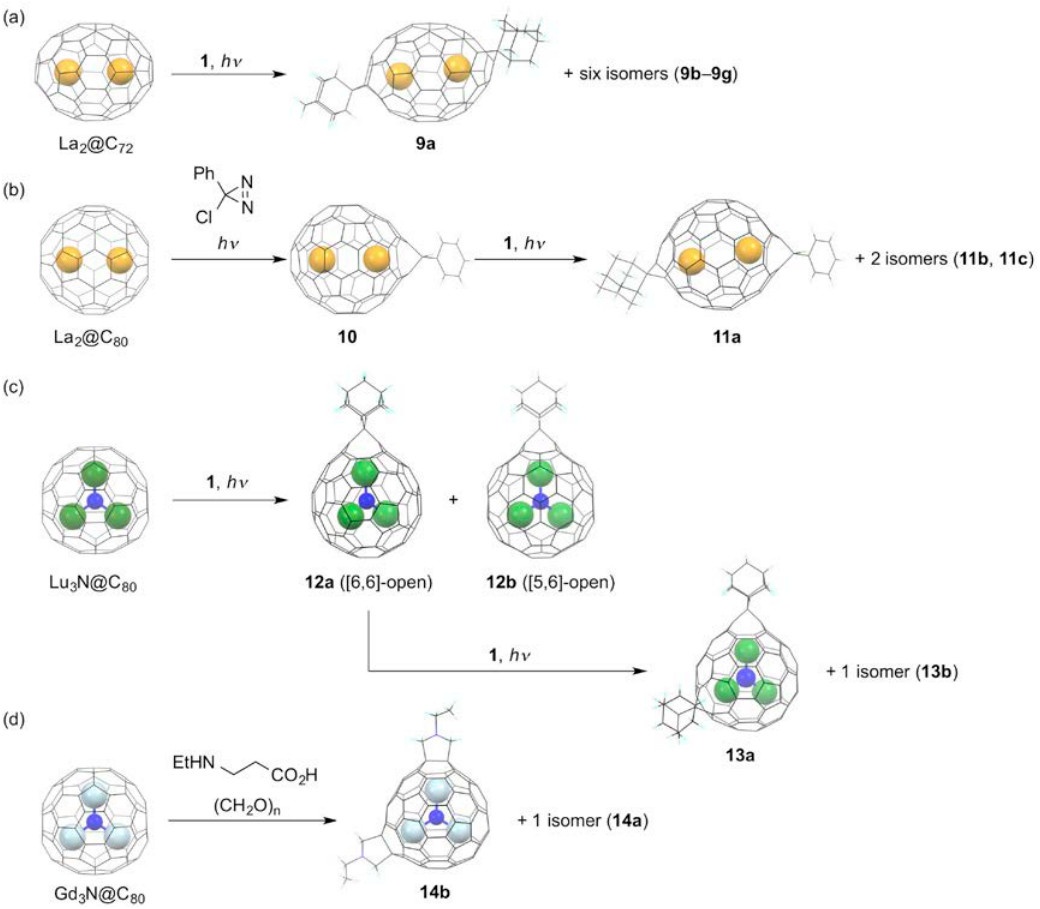
Figure 4. Bisfunctionalization of EMFs. ( a ) Photochemical reaction of La 2 @C 72 and 1 . ( b ) Two-step bisfunctionalization of La 2 @C 80 . ( c ) Two-step bisfunctionalization of Lu 3 N@C 80 . ( d ) Prato reaction of Gd 3 N@C 80 with N -ethylglycine and paraformaldehyde.